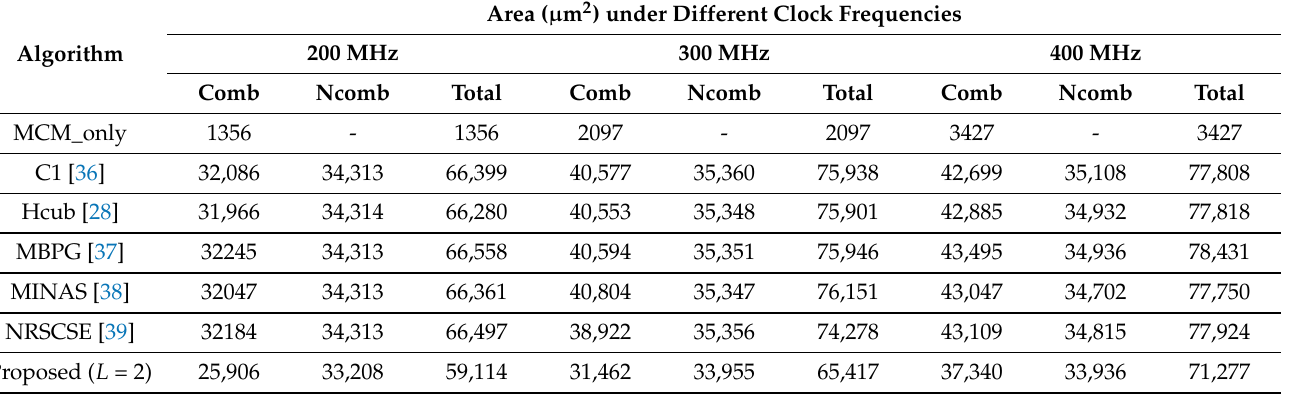
Table 4. Area comparison of the 418-tap filter with a 12-bit word-length (40 nm CMOS technology).